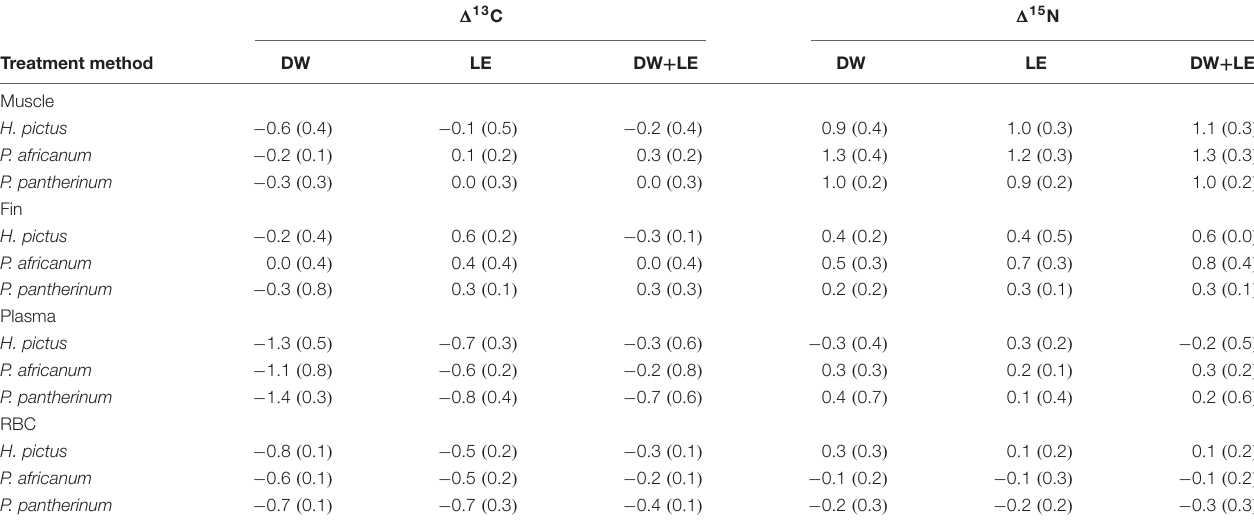
TABLE 2 | Results of ANOVAs investigating treatment method effects on muscle, fin, plasma, and red blood cell (RBC) δ 13 C and δ 15 N ratios and (cid:49) 13 C and (cid:49) 15 N offsets ( δ control − δ treatment ).